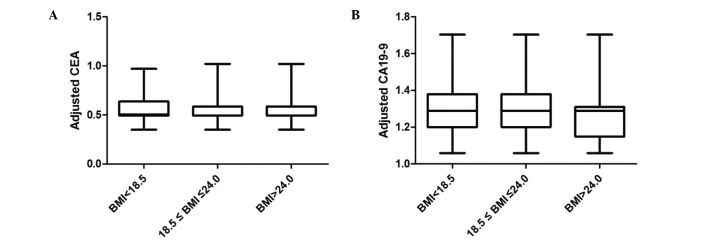
Adjusted CEA, CA19-9 results of the mathematical model. (A) Body mass index (BMI) <18.5, carcinoembryonic antigen (CEA)=0.55±0.13 ng/ml; 18.5≤BMI≤24.0, CEA=0.55±0.12 ng/ml; BMI≥24.0, CEA=0.54±0.12 ng/ml; P>0.05. (B) BMI<18.5, carbohydrate antigen 19-9 (CA19-9)=1.31±0.15 ng/ml; 18.5≤BMI≤24.0, CA19-9=1.28±0.12 ng/ml; BMI≥24.0, CA19-9=1.26±0.13 ng/ml; P<0.05. CEA, carcinoembryonic antigen; CA19-9, carbohydrate antigen 19-9.